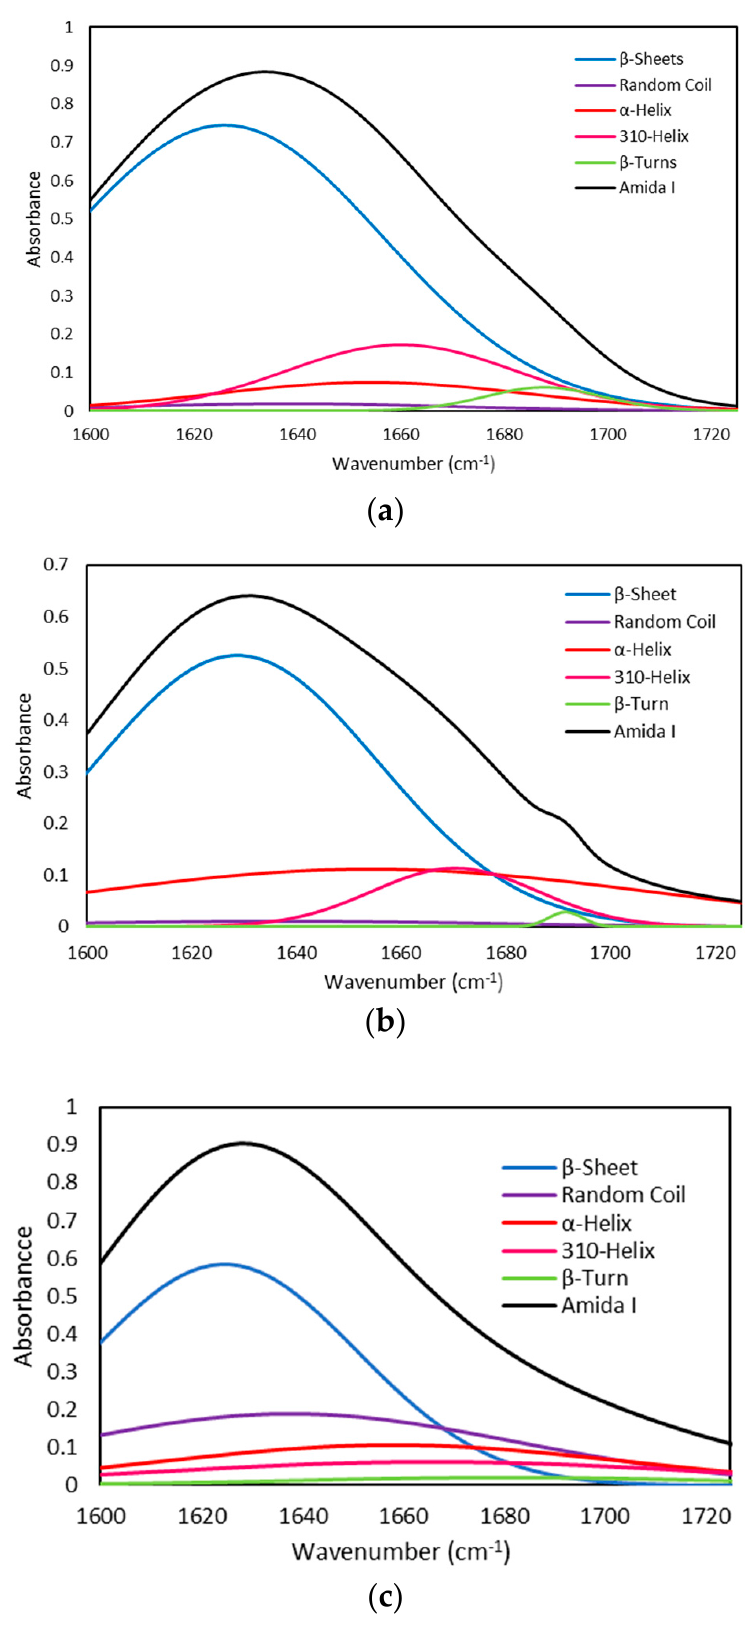
Figure 4. Amide I band decomposition by using Gaussian distribution. ( a ) Seabass, ( b ) Seabream, and ( c ) Trout gelatin. Table 6. Location and percent area contribution of the main secondary structures in the amide I region of seabass, seabream and trout gelatin. FWHM: Full width at half its maximum value, corre ‐ sponding to the widths of the central peaks of the autocorrelation traces. Gelatin Type